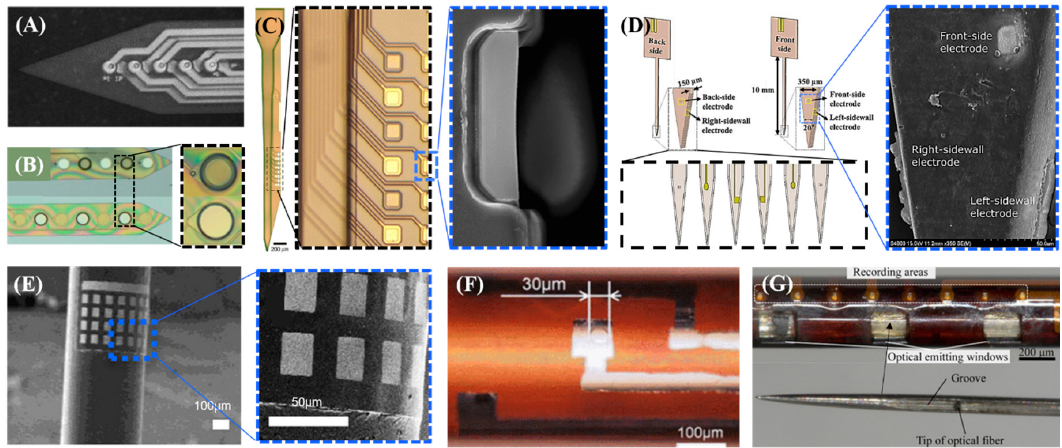
Figure 2. Featured multi-sided probes: ( A ) double-sided, transparent polyimide probe (reprinted from [134] with permission from Elsevier, Copyright 2002,); ( B ) double-sided polyimide probe fabricated using silicon posts for opening the electrode on the first metal layer reprinted from [138], with permission from IEEE, © 2012); ( C ) triple-sided parylene probe (reprinted from [140] with permission from Springer Nature Customer Service Centre GmbH); ( D ) four-sided probe based on a liquid crystal polymer (reprinted from [141] with permission from Elsevier, Copyright 2017,); ( E ) Nanoelectronics coating onto optical fiber using Van der Waals interaction (reprinted from [109] with permission from The American Chemical Society, Copyright 2017); ( F ) parylene/polyimide hybrid probe fabricated by direct patterning on a cylindrical surface (reprinted, from [107] with permission from IEEE, © 2017); ( G ) tube-shaped polyimide probe in which a sharp metal needle and optical fiber are embedded (reproduced from [106] with permission from John Wiley & Sons, copyright